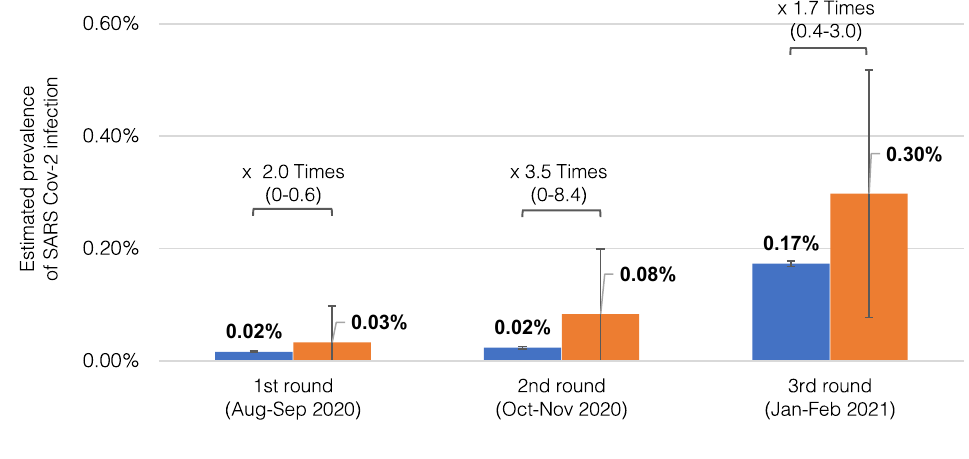
Fig. 3 Comparison of anti-SARS-Cov-2 antibody seroprevalence with the prevalence of con fi rmed COVID-19 cases in Hiroshima Pre- fecture Blue bars represent the prevalence of SARS-CoV-2 infections in Hiroshima Prefecture, estimated by dividing the number of o ffi cially announced COVID-19 cases by the total population in Hiroshima Prefecture. Orange bars show the seroprevalence of anti-SARS-Cov-2 antibody, de fi ned as at least two positive results from the four immunoassays (Vitros Anti – SARS-CoV-2 Total, Vitros Anti – SARS-CoV-2 IgG, Roche Elecsys Anti – SARS-CoV-2, and Architect Abbot SARS-CoV-2 IgG) in each of the three survey rounds. The seroprevalence is assumed to represent the actual proportion of people with prior SARS-CoV-2 infection, including asymptomatic cases not identi fi ed by o ffi cial reports. The proportions of people with prior SARS-CoV-2 infection were 1.7 to 3.5 times higher than the prevalence of con fi rmed COVID-19 cases in Hiroshima